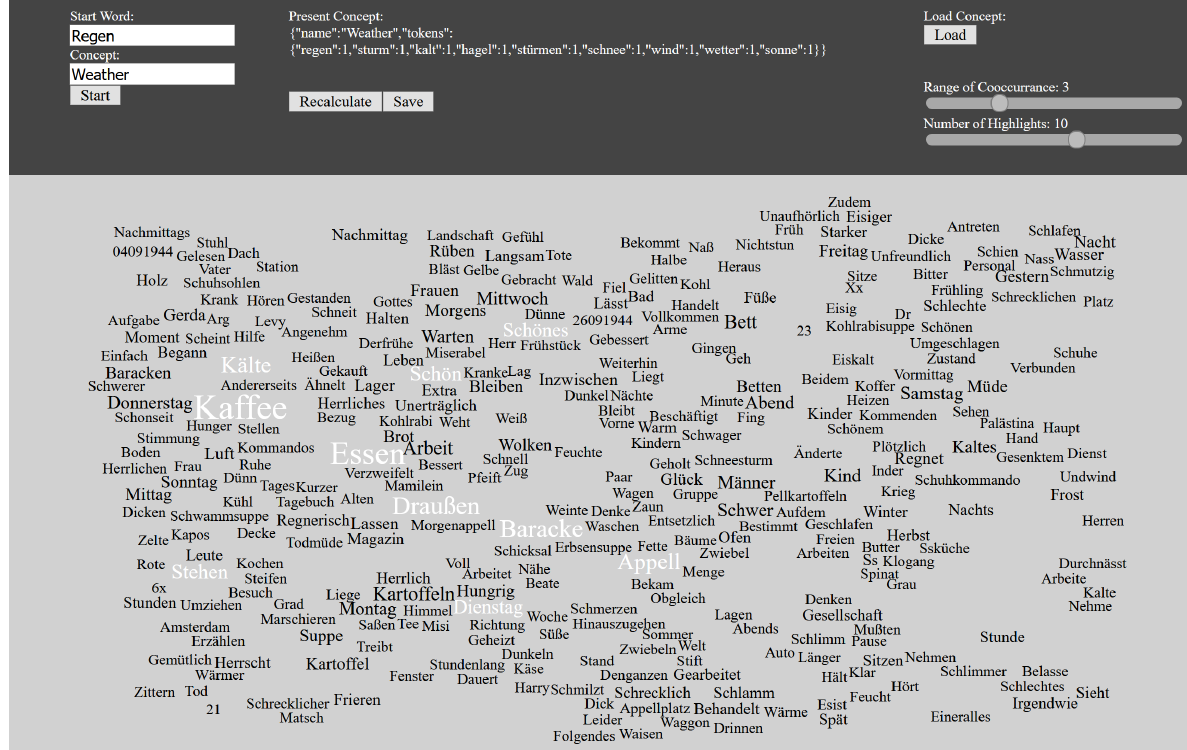
Figure 8. After finishing the concept, the "Save" button exports the constructed concept as